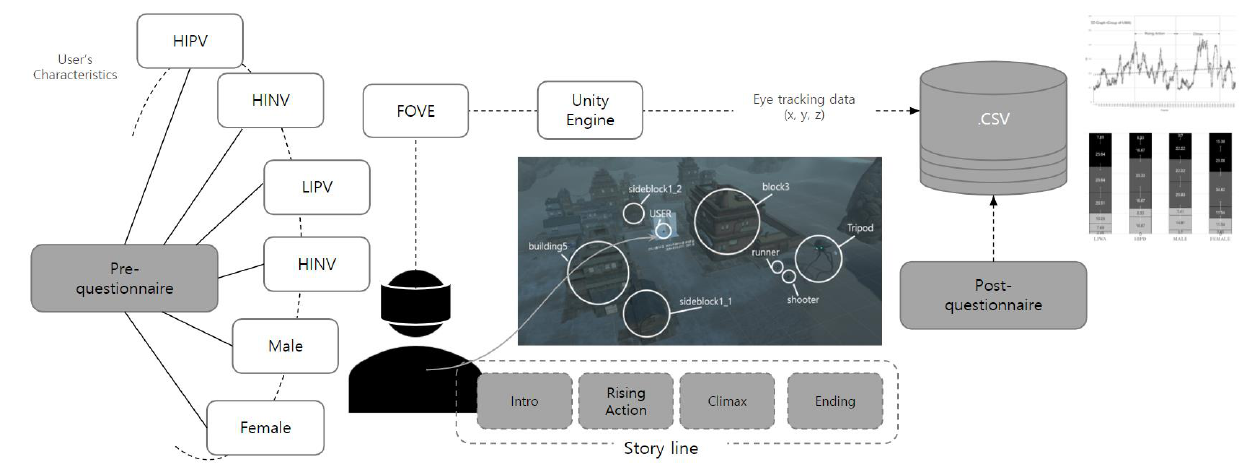
Figure 2. An overview of the study.